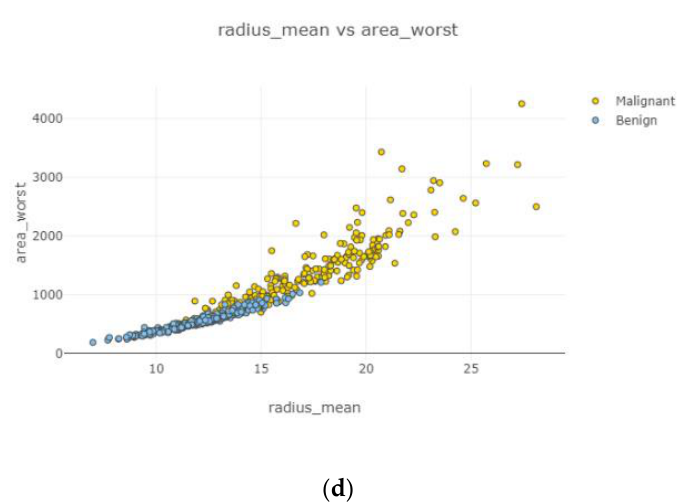
Figure 9. Positively correlated scatter plots 1–4.